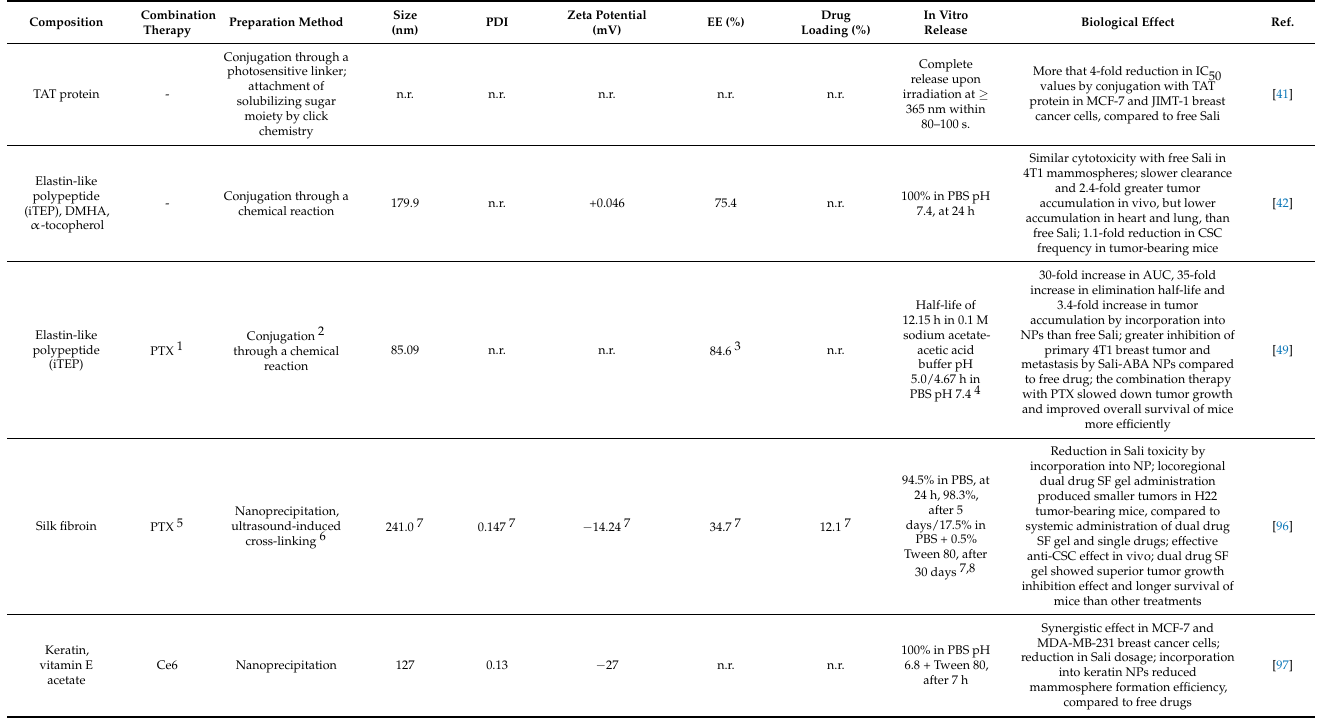
Table 7. Polypeptide- and protein-based nanosystems with